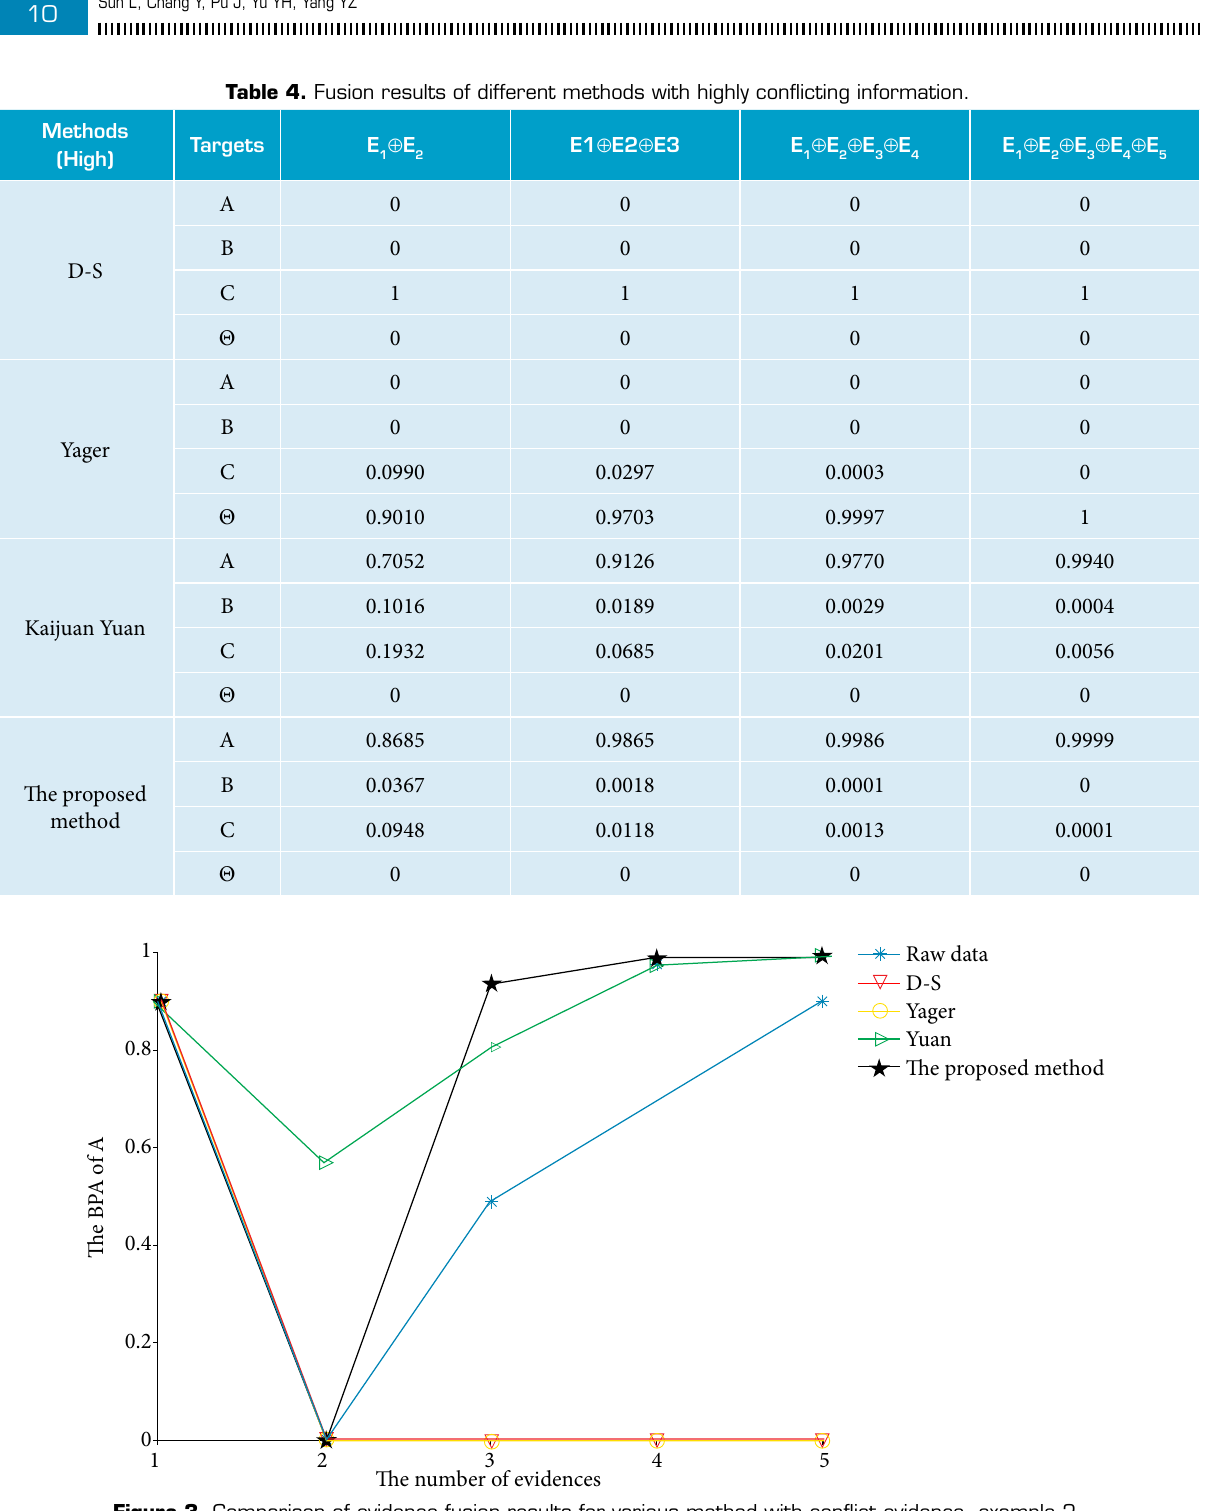
Figure 3. Comparison of evidence fusion results for various method with conflict evidence, example 2.